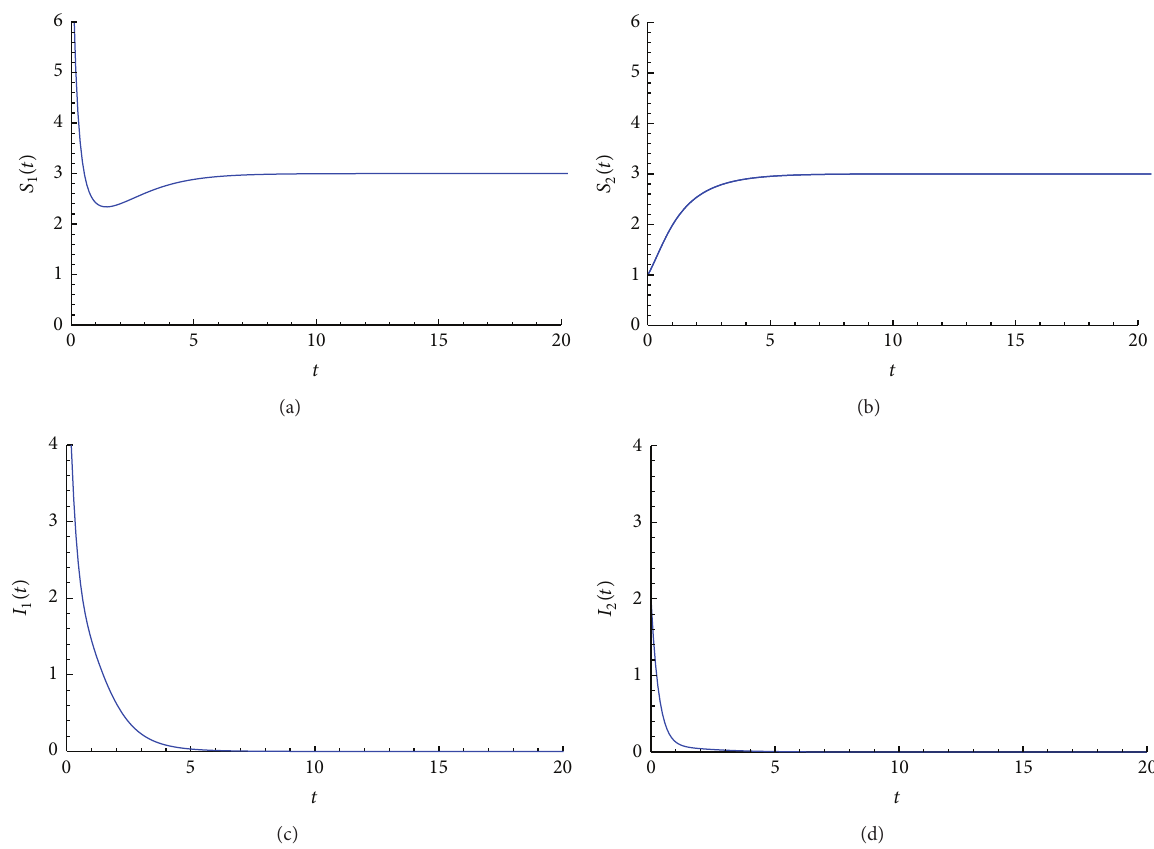
Figure 1: Trajectories of 𝑆 1 (𝑡),𝐼 1 (𝑡),𝑆 2 (𝑡) , and 𝐼 2 (𝑡) for 𝑅 0 = 0.051 < 1 , and 𝑃 0 = (3, 0, 0,0, 3, 0, 0,0) is globally stable. 𝑆 1 (𝑡), 𝑆 2 (𝑡), 𝐼 1 (𝑡) , and (𝑡) versus 𝑡 are illustrated by (a), (b), (c), and (d). Initial values are 𝑆 𝐼 2 (0) = 6 , and 𝐼 (0) = 2 0, 𝐼 1 2